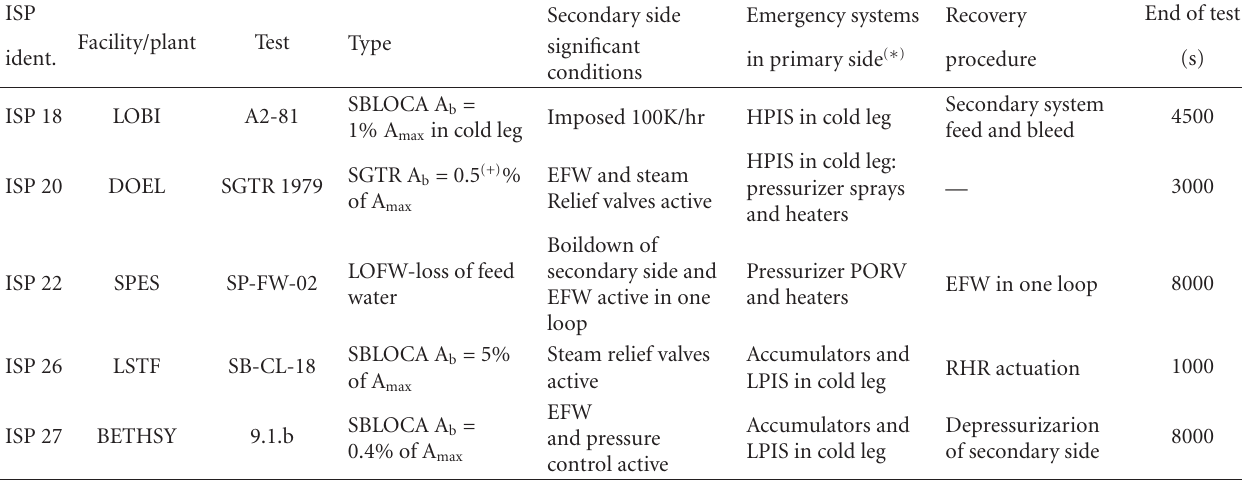
Table 4: Main characteristics of the considered